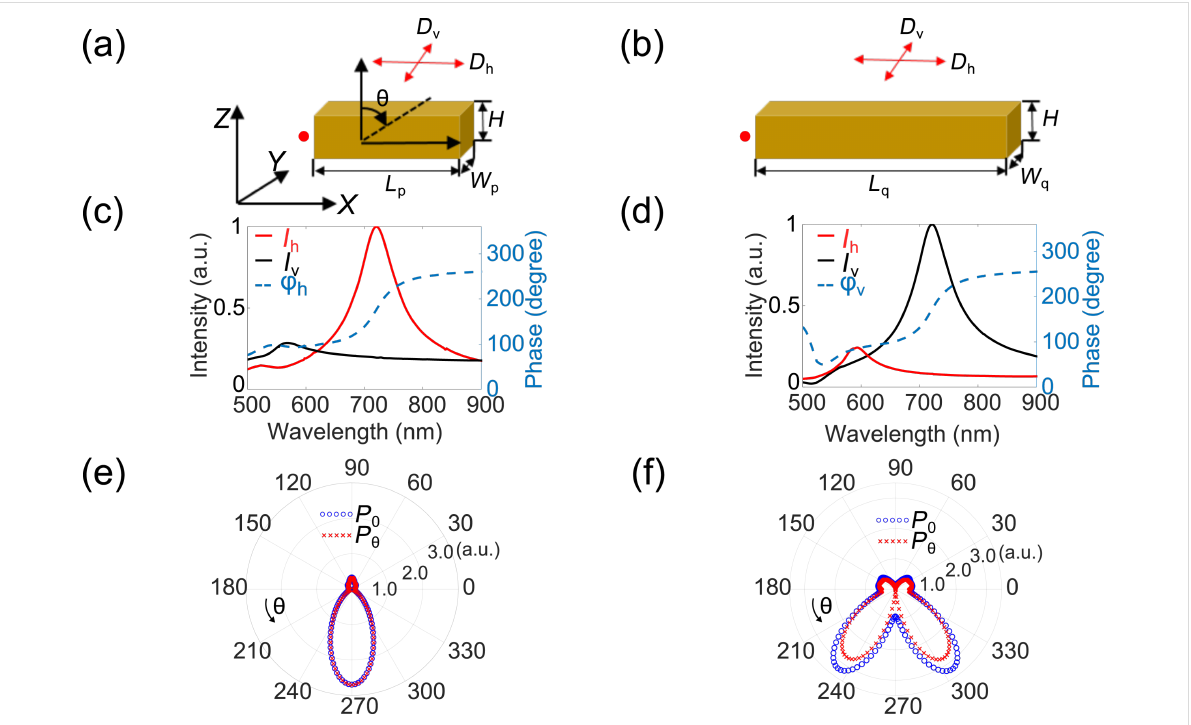
Figure 2: Characteristics of the bar antenna excited by an electric dipole emitter. (a, b) Schematic of the simulation setup for the short bar (a) and the long bar (b) antenna, respectively. The red arrows represent point-dipole emitters with X or Y orientations. The red spots represent electric probes. (c, d) The electric field intensity ( I ) and phase ( φ ) at the position of the probe when point-dipole emitters oriented along X and Y are used as an excita- tion source for the short and long bar, respectively. The subscript h and v represents the field induced by the point-dipole emitter along X and Y direc- tions, respectively. We only show phase information for the short bar excited by a X -orientated emitter ( φ h ) and the long bar excited by a Y -oriented emitter ( φ v ). The field intensity is normalized to the larger one for emitters with different orientations. (e, f) Polar plot of the total ( P 0 ) and azimuthal components ( P θ ) of the far-field power distribution when the short bar is excited by a X -oriented dipole (e) and the long bar is excited by a Y -oriented dipole (f), respectively. The direction of θ is illustrated by arrows.